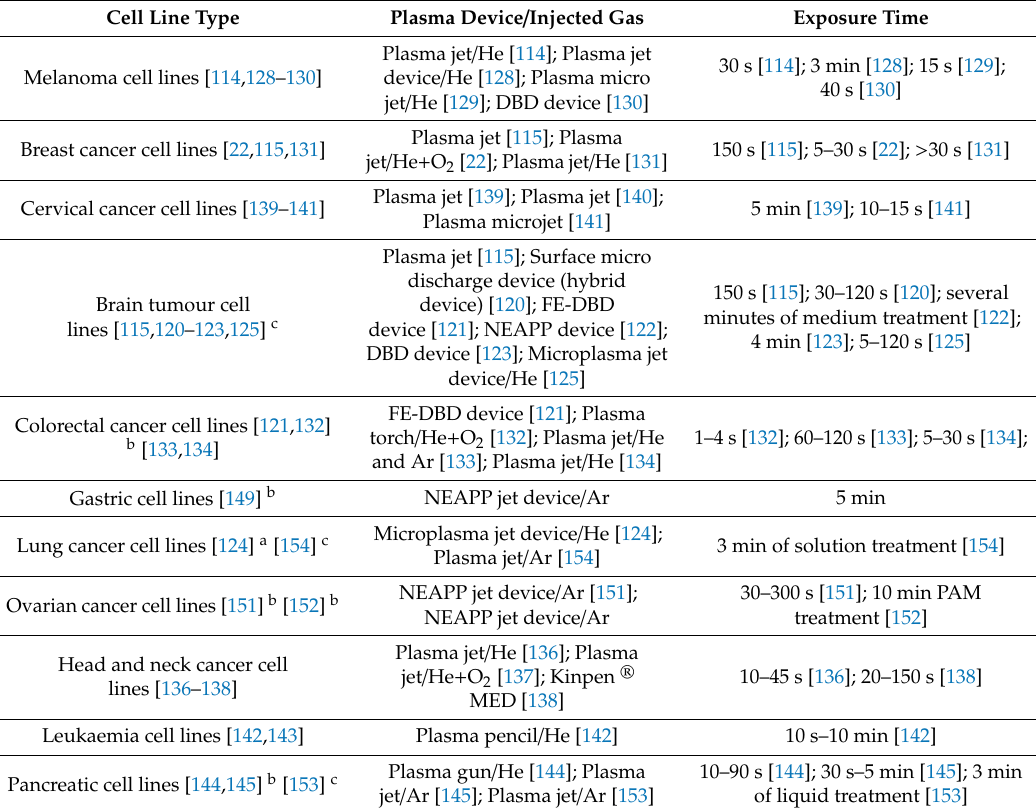
Table 5. List of cold atmospheric plasma (CAP) in vitro applications for tumour